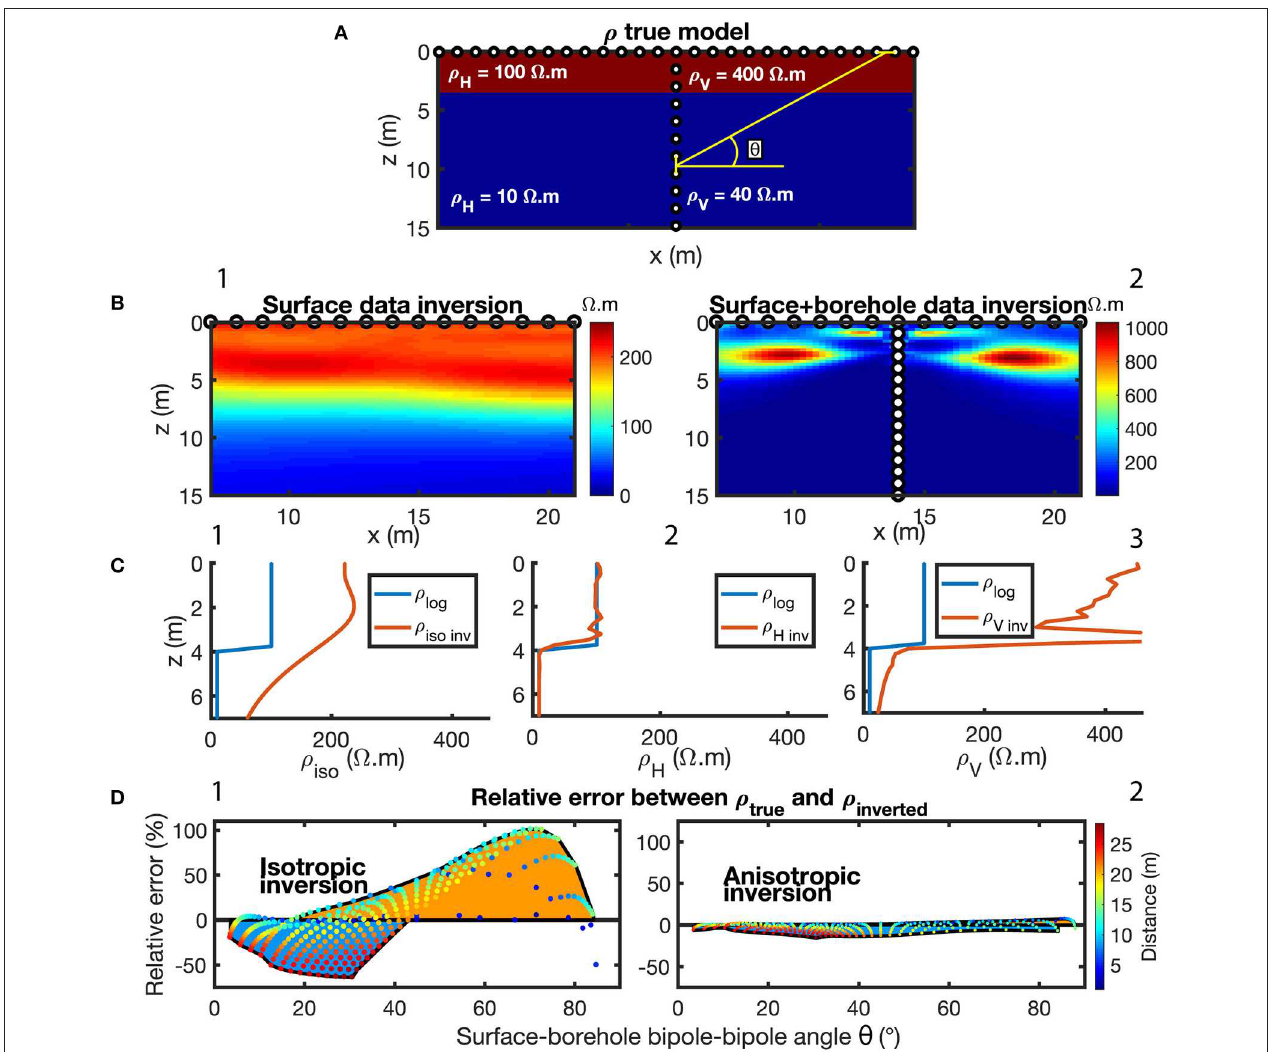
FIGURE 2 | (A) Synthetic model, constituted of an anisotropic layer over an anisotropic semi-infinite space. Upper layer: ρ H Semi-infinite space: ρ H 10 (cid:127) . m and ρ V 40 (cid:127) . m . λ 2 for the whole model. Electrodes (white dots) are located at the surface and in-hole borehole at x = = = In yellow is shown an example of surface-borehole measure angle (D) . (B) (section 3.2.1) Isotropic inversions of potentials acquired using (B.1) only surface